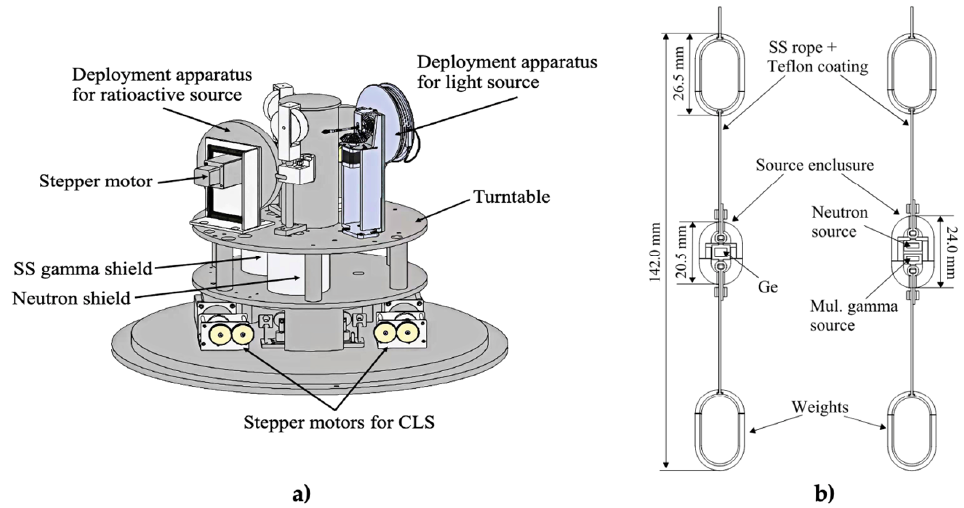
Figure 3. ( a ) Automated calibration system as used before in the Daya Bay Experiment [14]. The steel dome housing the ACU on top of the detector is not shown here. ( b ) Schematic drawing of the source holding structure. The 68 Ge source (left) and a combined radioactive source (right). The combined source contains multiple γ emitting isotopes ( 137 Cs, 54 Mn, 40 K, 60 Co) and one neutron source ( 241 Am– 13 C). Figures taken from [10] and